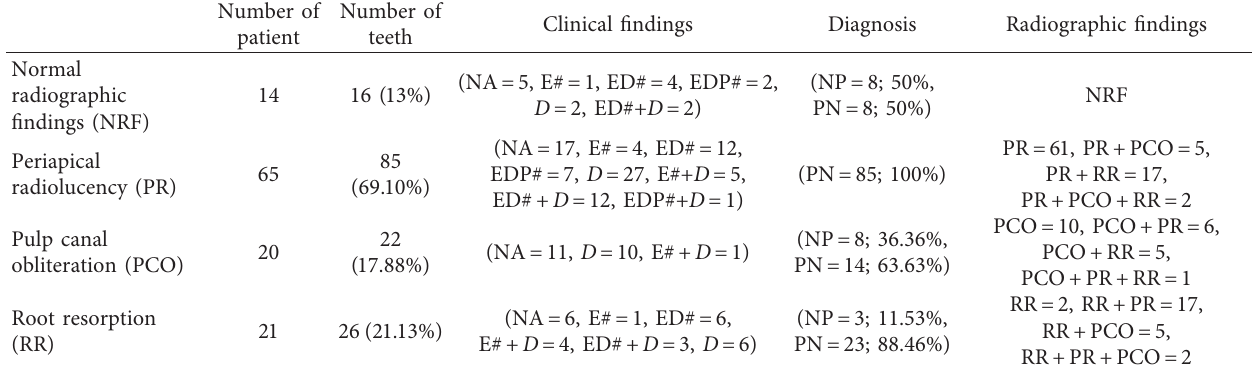
Table 6: Distribution of radiographic